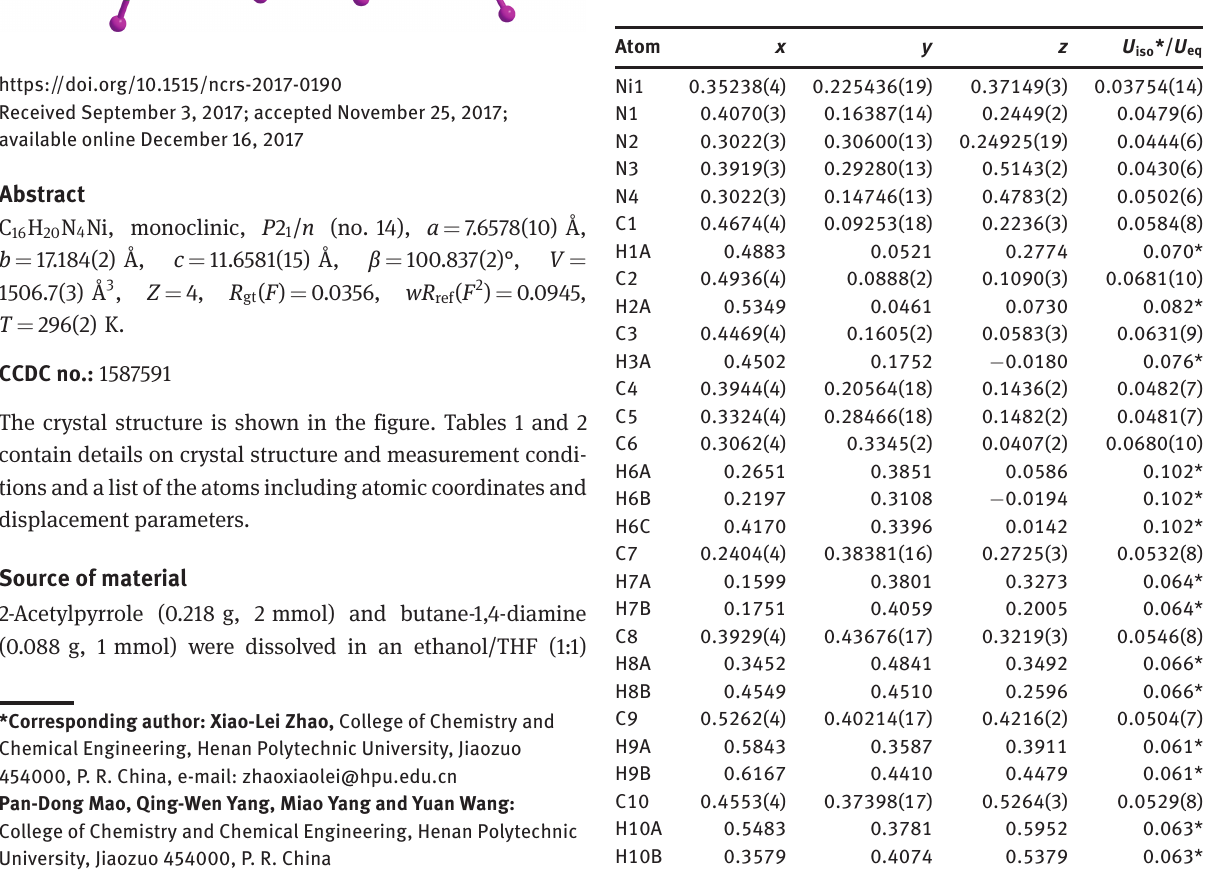
Table 2: Fractional atomic coordinates and isotropic or equivalent isotropic displacement parameters (Å 2